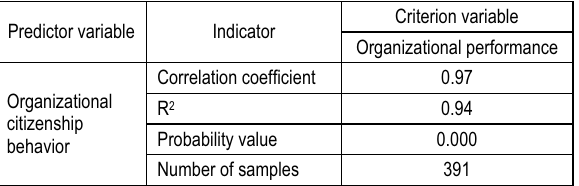
Table 3. The relationship between organizational